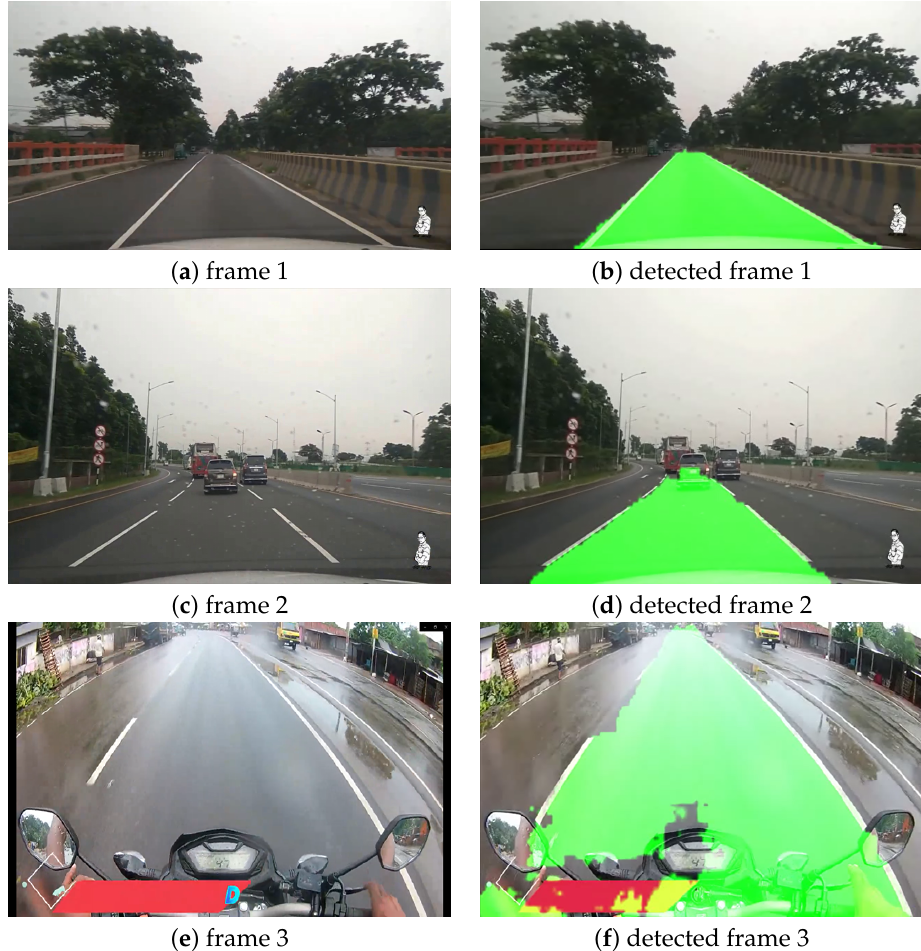
Figure 7. Visualization of lane detection in rainy weather condition. Night